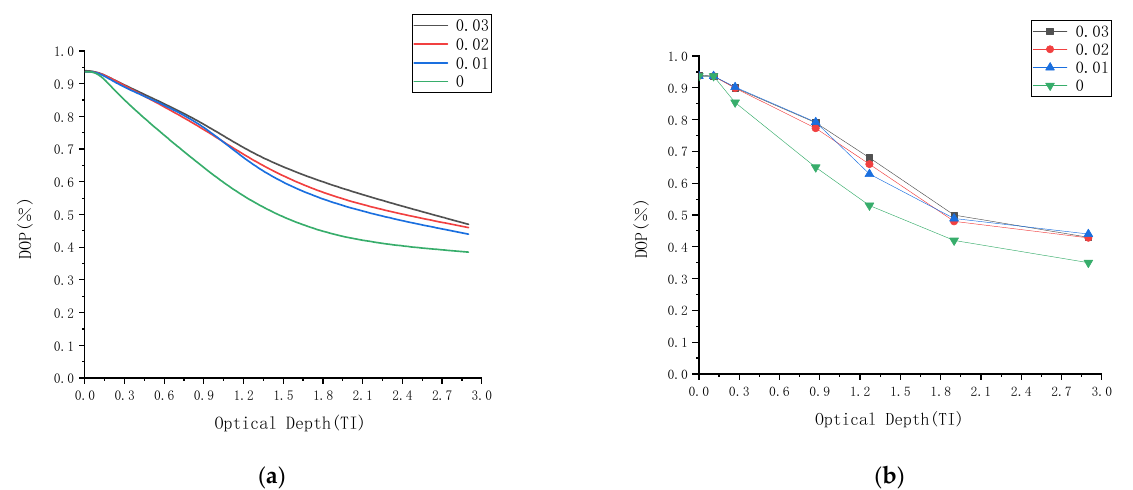
Figure 6. Simulation and experimental comparison of the relationship between salt content at 532 nm and DOP: ( a ) simulation results and ( b ) experimental results.